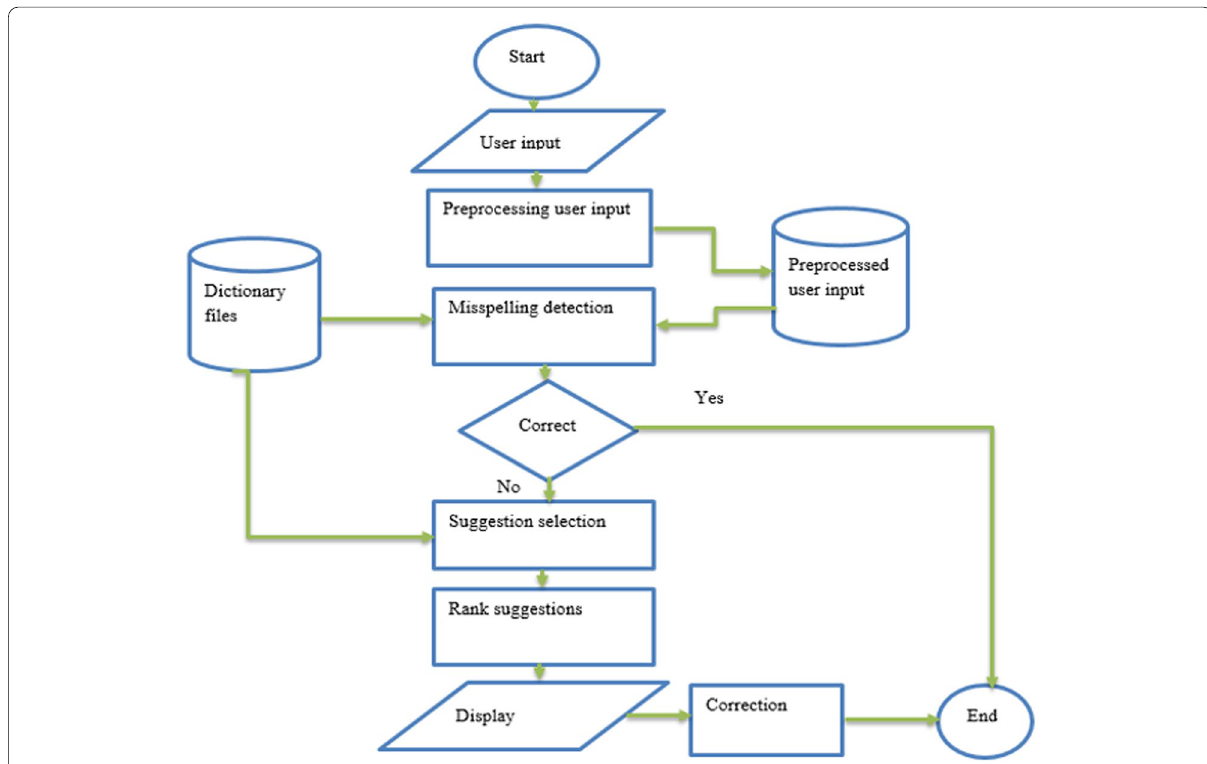
Fig. 1 Workflow of the proposed